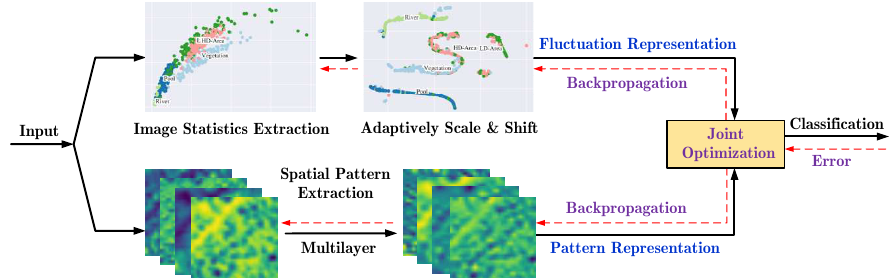
Figure 3. Framework of the proposed PSNet. The representation learned by the PSNet not only describes the average fluctuation of the input, but also captures the spatial pattern of the